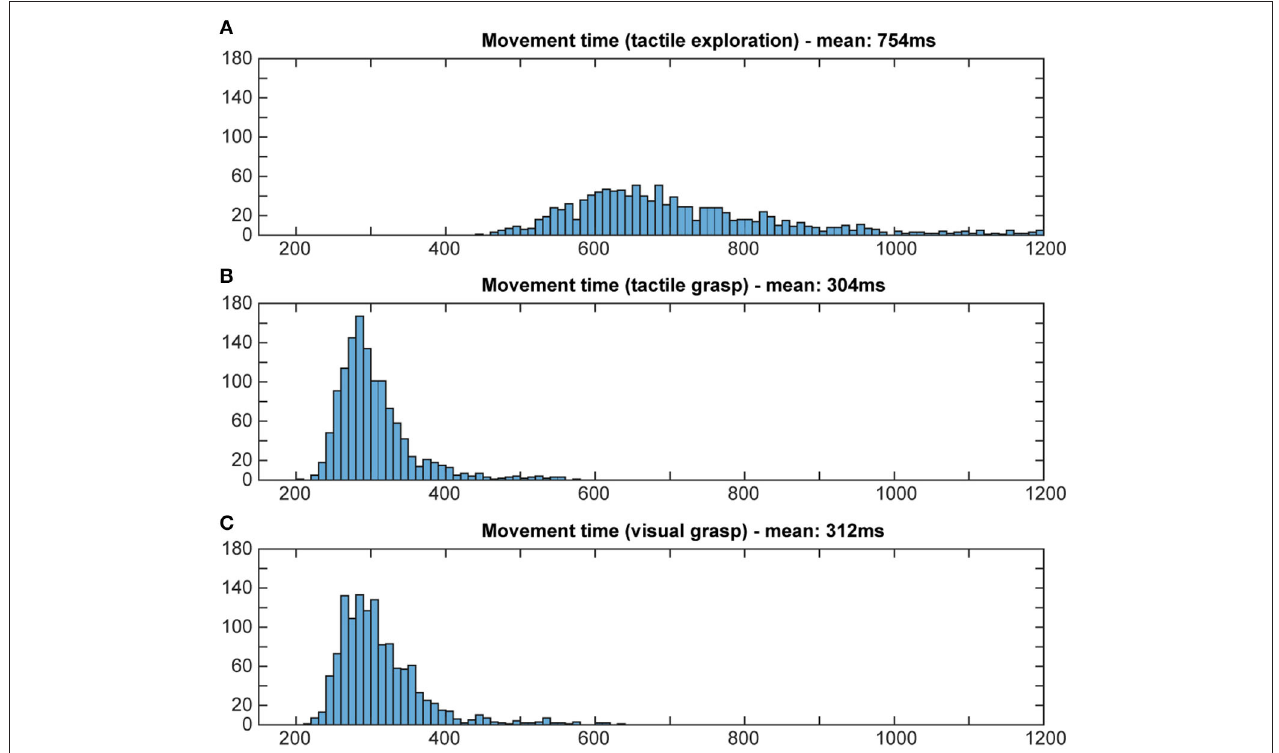
FIGURE 9 | Distribution of movement times. Histograms illustrate how often a certain movement time occurred in both tasks. Bin width: 10 ms, cut off at 1,200 ms. During tactile exploration (A) the object was unknown, leading to multiple and varying grasp attempts and on average a much longer movement time. For grasp movement execution in the tactile (B) and visual grasps (C) a similar movement time can be observed, indicating that the animal was able to execute an appropriate grasp for the object based on the object information gathered from the object presentation